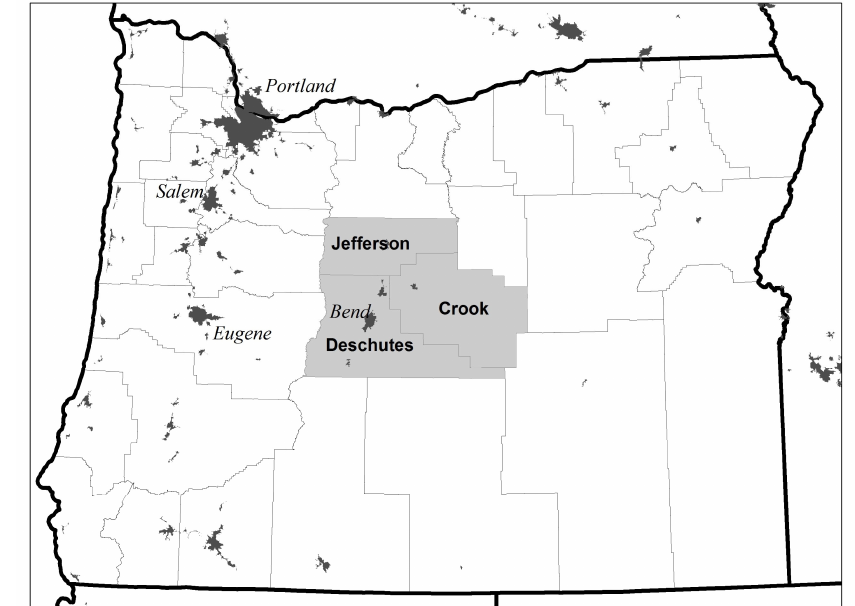
Figure 1. Central Oregon Counties and the City of Bend Shown within the State of